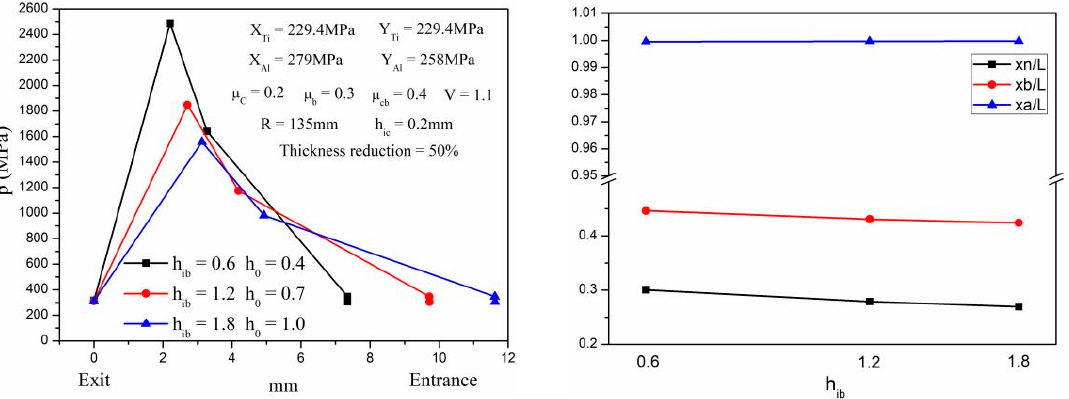
x , x and x , a b n